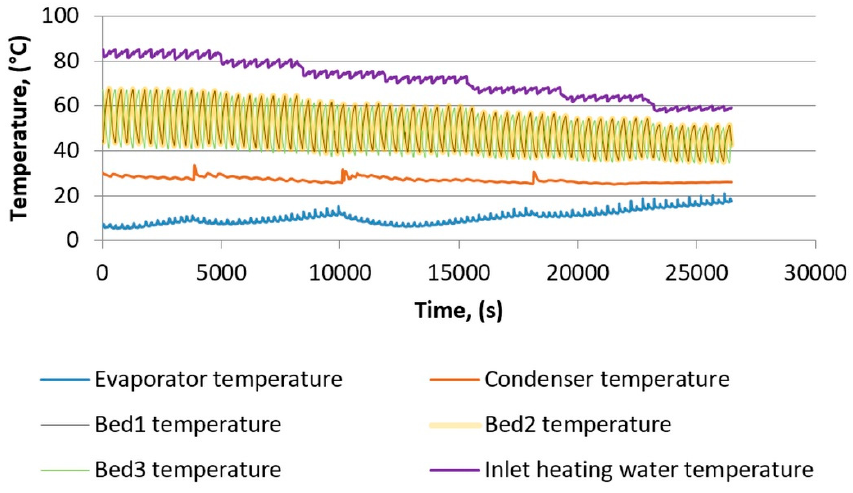
Figure 7. The changes in the evaporator, condenser, and bed temperatures in the function of